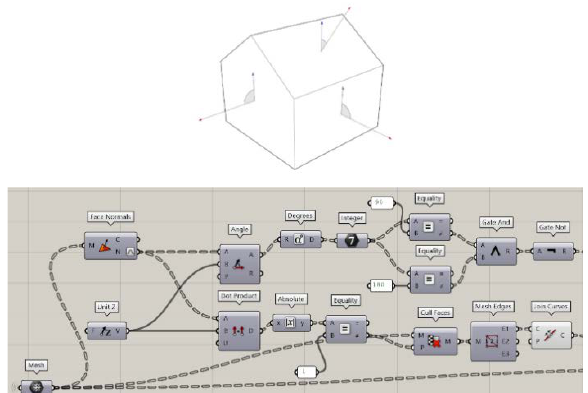
Figure 10. The incline of plan to describe the parts of